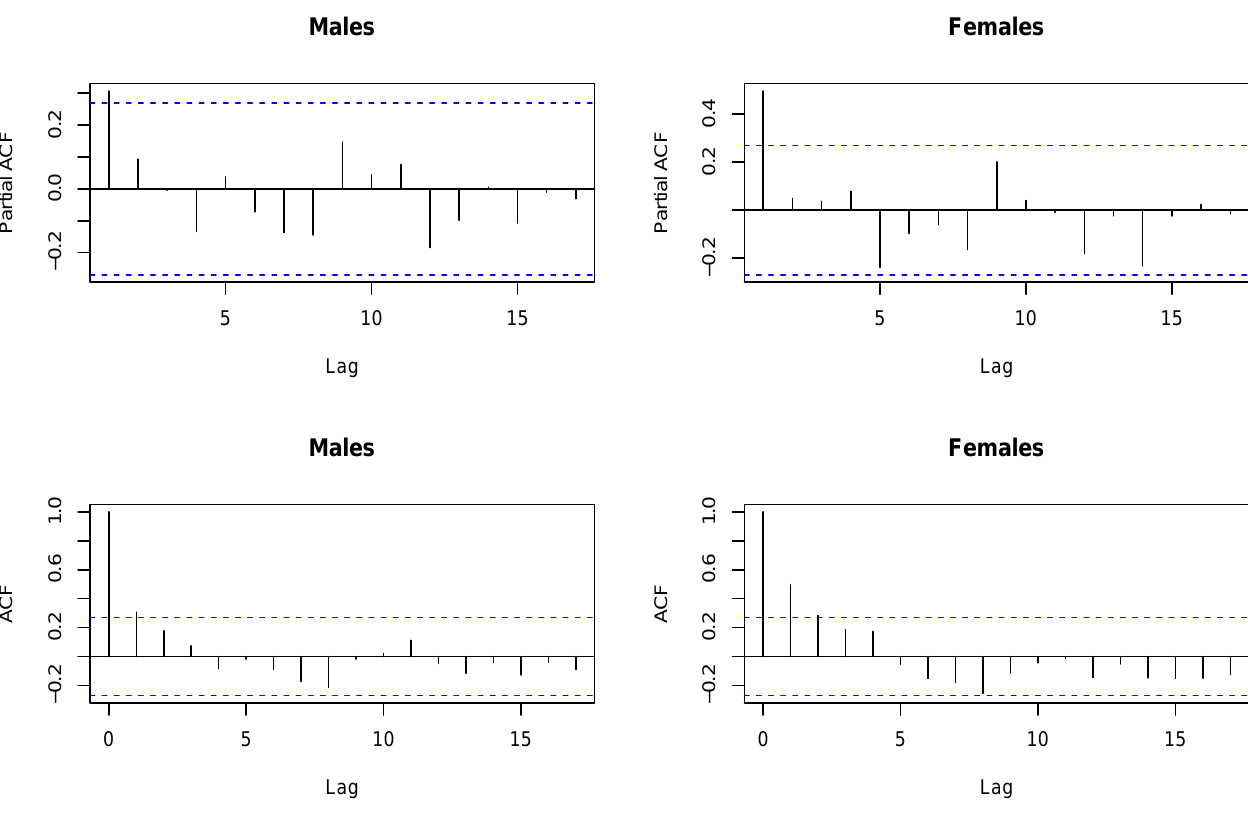
Figure 2. Order checking of fitted time series. Top row : partial autocorrelation function. Bottom row : autocorrelation